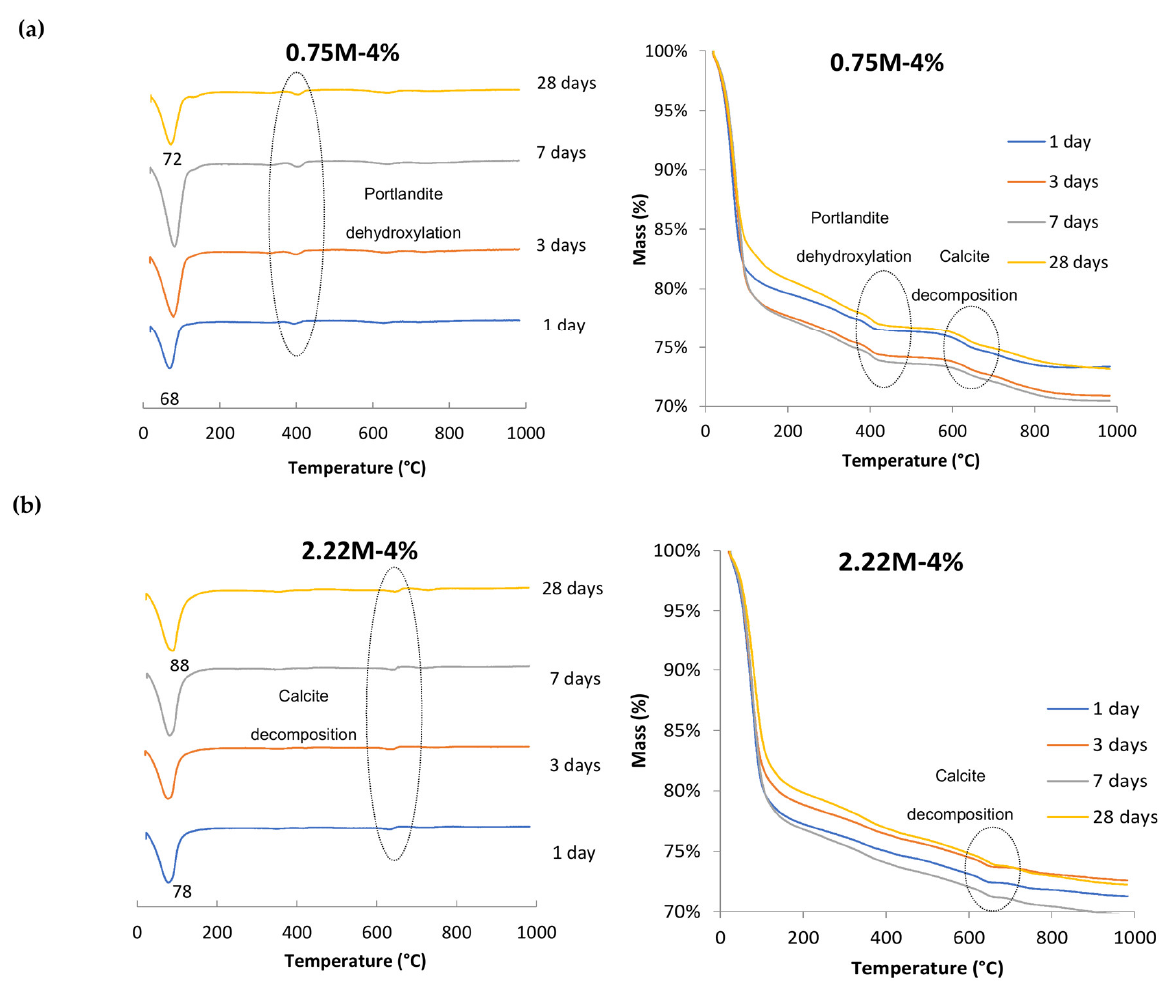
Figure 11. TG/DTG of ( a ) 0.75M-4% and ( b ) 2.22M-4%.